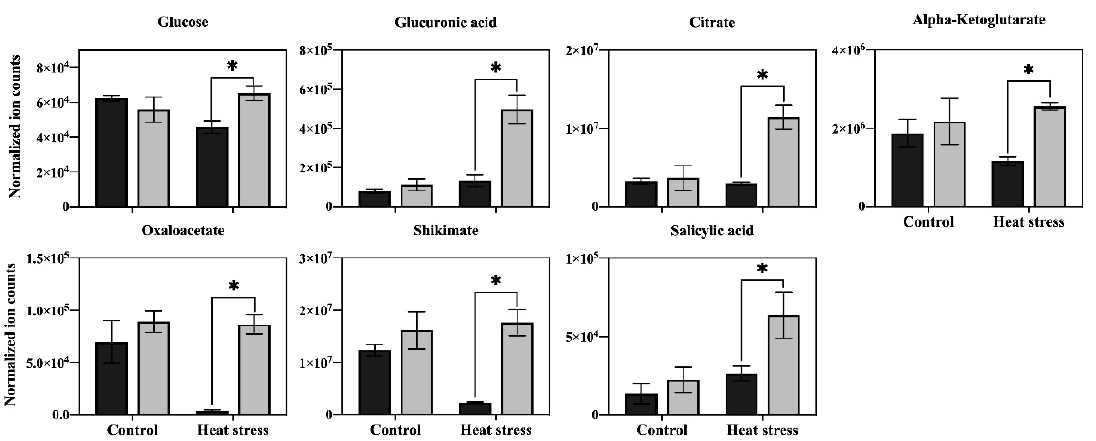
Figure 5. Effects of exogenous application of aspartate (Asp, 2 mM) on the content of sugars and organic acids in leaves of perennial ryegrass under control temperature and heat stress (30 d of treatment). Vertical bars over the column represent standard errors of a given data point, and * represents significant differences between water and Asp under control temperature and heat stress based on the LSD test at p = 0.05.